Question: Express in one sentence what the figure is showing.
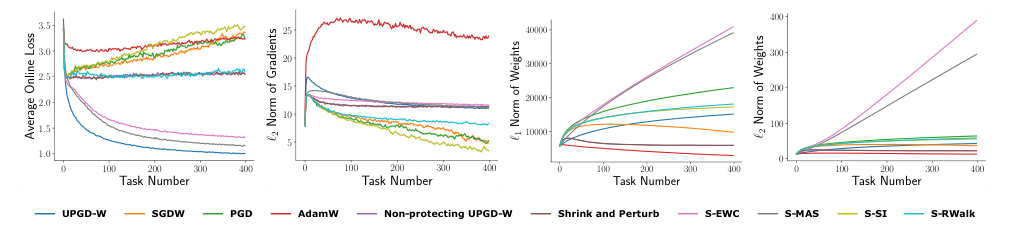
Answer: Diagnostic statistics of methods on Label-permuted EMNIST. The average plasticity, percentage of zero activations, ℓ0, ℓ1 and ℓ2-norm of gradients, the average online loss, the ℓ1-norm and ℓ2-norm of the weights are shown. The shaded area represents the standard error.